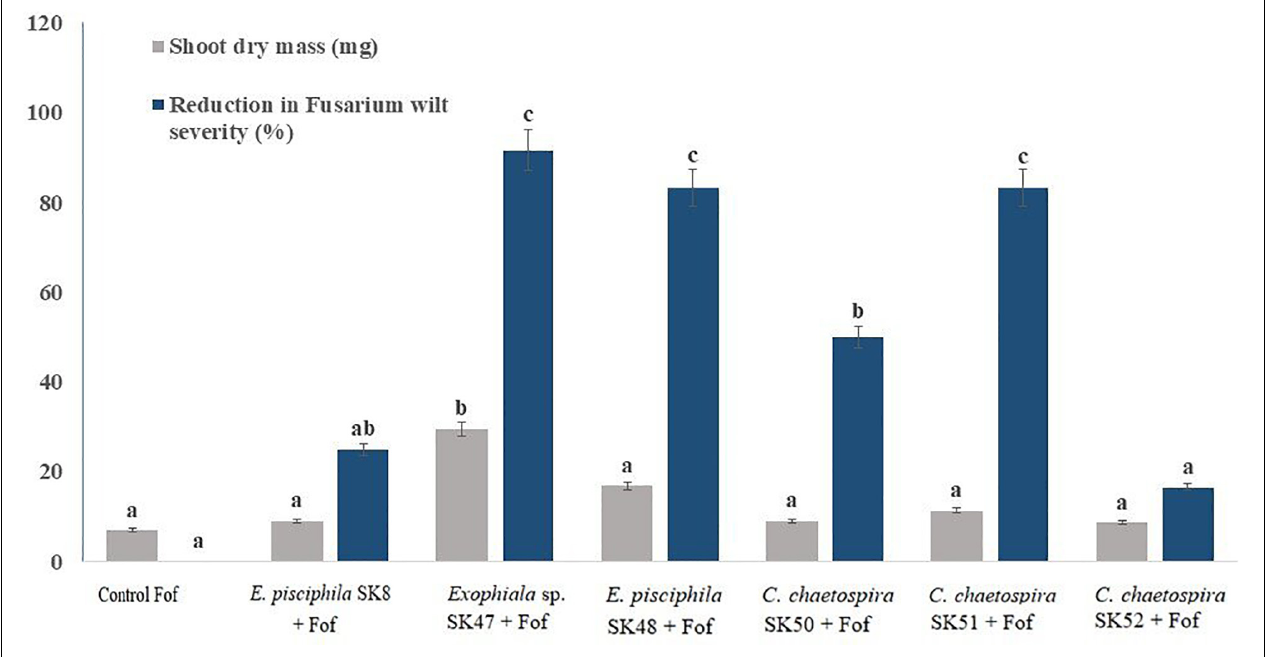
FIGURE 2 | Efficiency of E. pisciphila SK8, Exophiala sp. SK47, E. pisciphila SK48, C. chaetospira SK50, C. chaetospira SK51, and C. chaetospira SK52 in suppressing Fusarium wilt. Bars with the same lowercase letter are not significantly different according to Tukey’s honestly significant difference test at p < 0.05. Error bars represent standard error of mean ( n = 3).